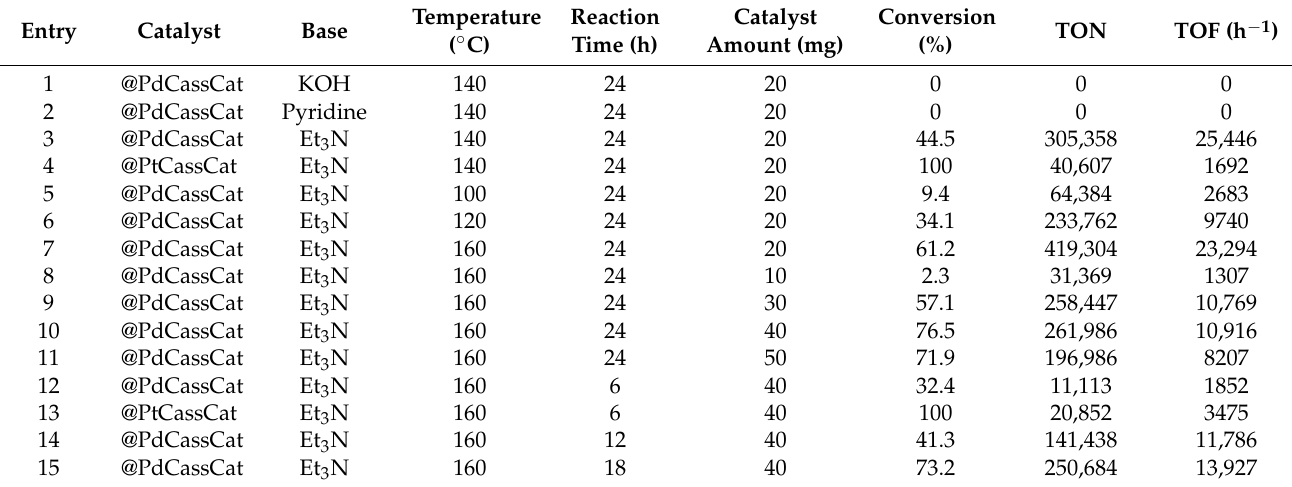
Table 5. Hydrogenation of furfural to furfuryl alcohol.